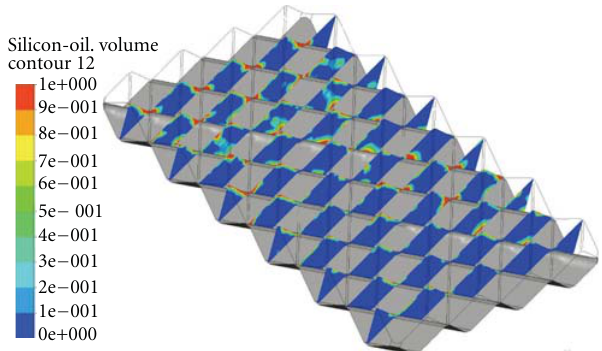
Figure 19: Contour of silicon-oil volume fraction at di ff erent heights of corrugated sheet of packing simulated along the flow direction for inlet position 1. Vol. Flow rate = 811 mL/min.